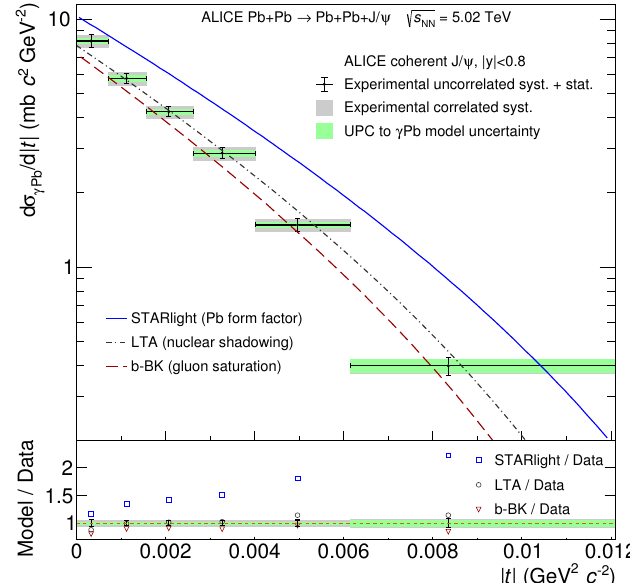
Figure 17. Photo production of J / ψ at very low values of t compared to Starlight data [75], leading − twist approach (LTA) [79], and b-BK saturation model [78]. Figure from the work in [77].